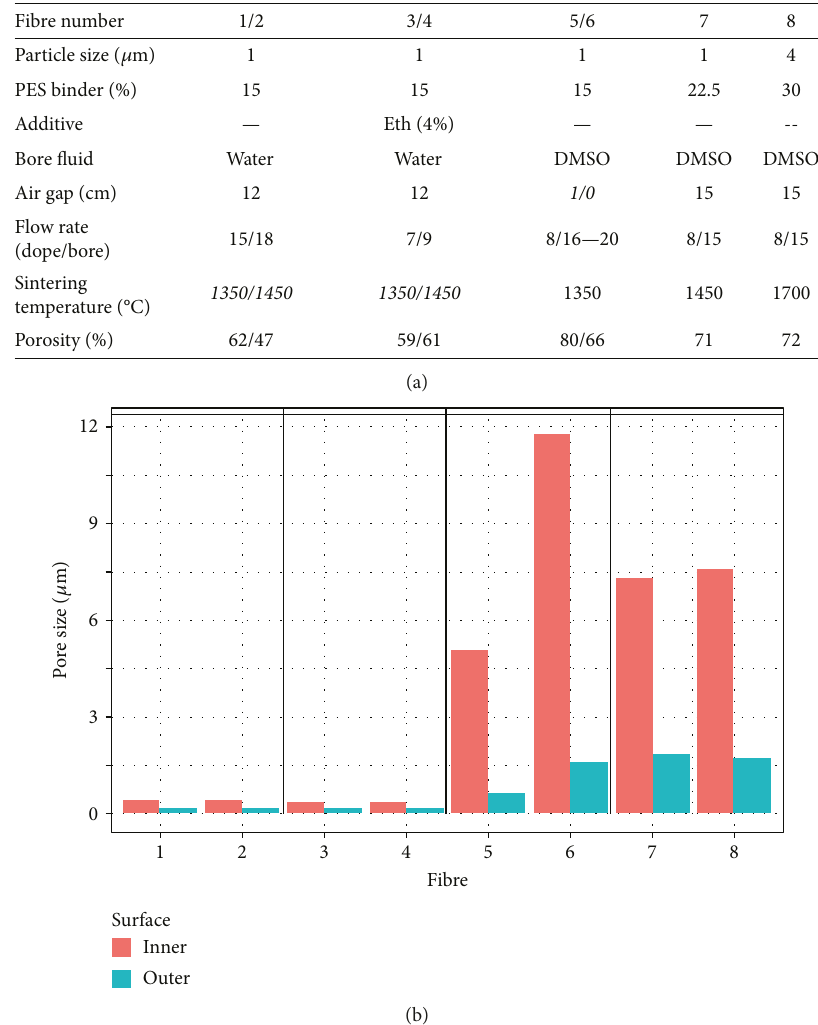
Figure 2: E ff ect of fabrication parameters on fi bre porosity. (a) Table of fi bre fabrication parameters producing structural di ff erences in porosity and pore size. Texts in italics identify varied parameters of the fi bre/group. (b) Outer and inner surface average pore diameter measured by MIP. Fibres 1 and 5 were de fi ned as the “ water fi bre ” and “ DMSO fi bre ” ,